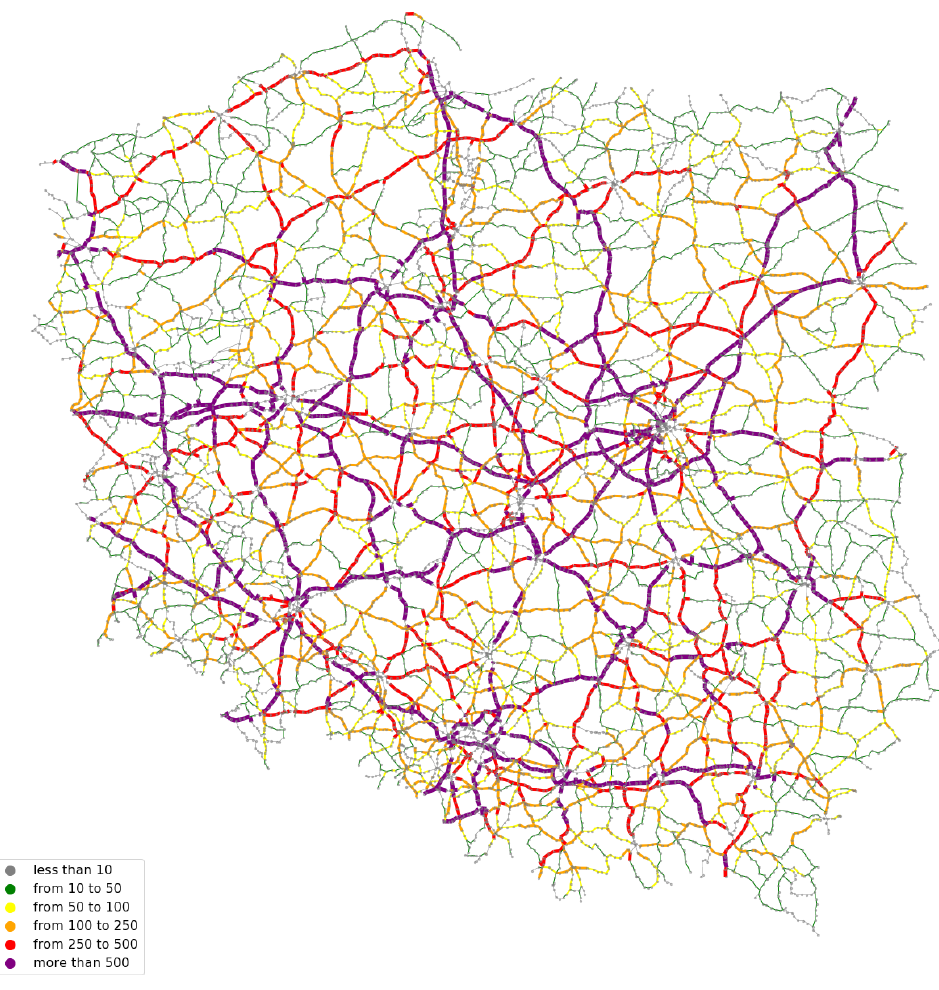
Figure 8. Traffic volumes on the road network according to GTM 2015. Table 5. Structure of the traffic volumes sample from GTM 2015.